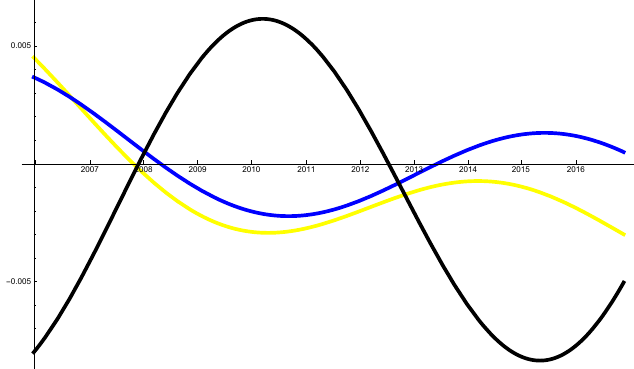
Figure 4. The x -axis represents time. The y -axis represents the value of the interaction coefficients of SOLAR (yellow), WIND (blue), and WTI (black) between 2006 and 2016.